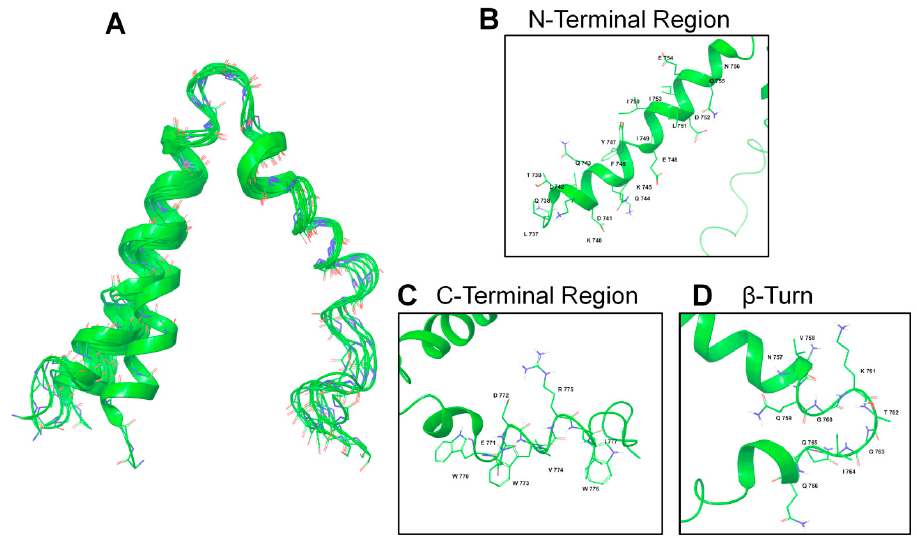
Figure 4. NMR structure of ( 15 N- 13 C)-labelled 737-786 gp36 CHR–MPER in DPC / SDS 90:10 M / M. ( A ) Ribbon of the representative structure of the calculated ensemble; ( B ) N-terminal region, consisting of the N-helix residues Q 738 -N 756 ; ( C ) C-terminal region containing the C8 peptide; ( D ) β -turn region containing residues N 757 –Q 766 .